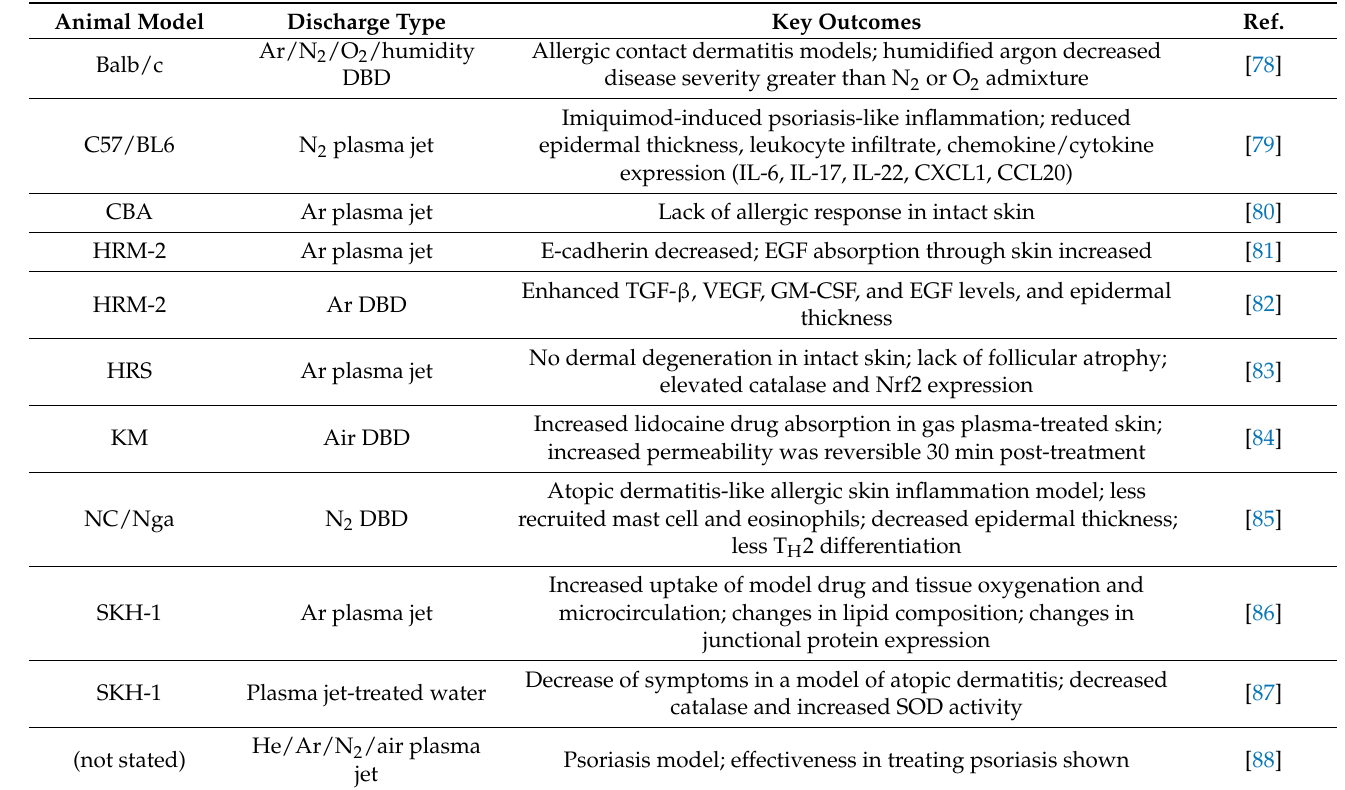
Table 1. Cont. Key Outcomes